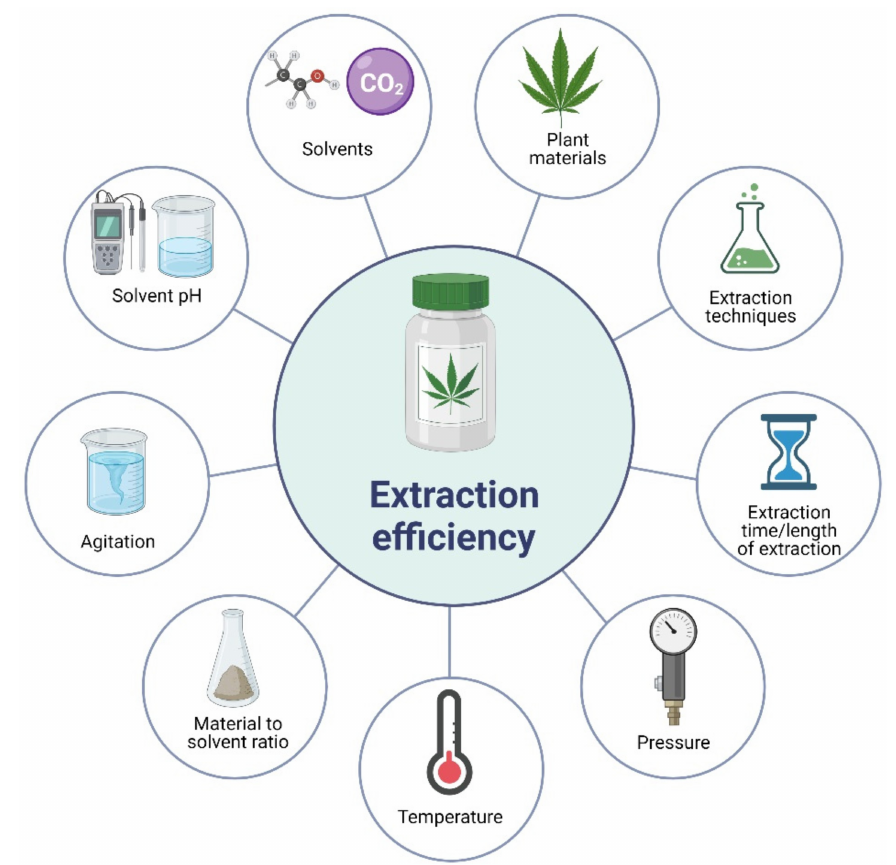
Figure 3. Factors affecting the extraction efficiency of plant bioactive